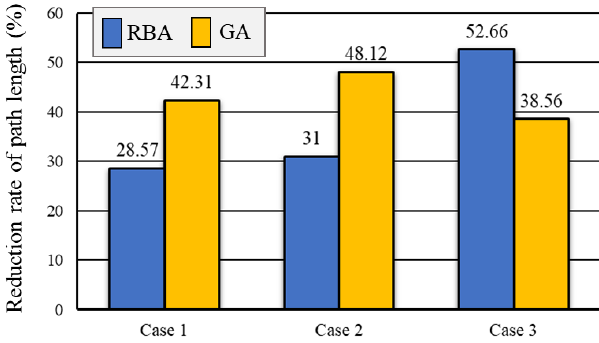
Figure 12. The distance reduction rate of path obtained by OA relative to RBA and GA.